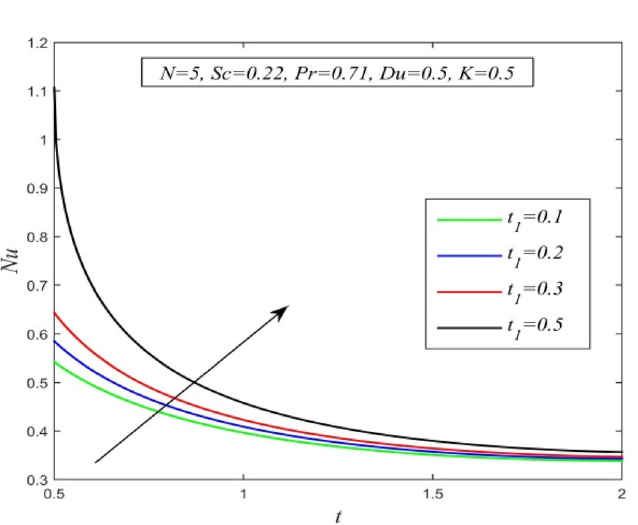
Figure 37. u versus y for different t 1 and t = 1, Sc = 0.22, K = 3, N = 5, Pr = 0.71, Du = 0.5, M = 0.5, K* = 1, Gr = 1, Gm = 5, a = 1.